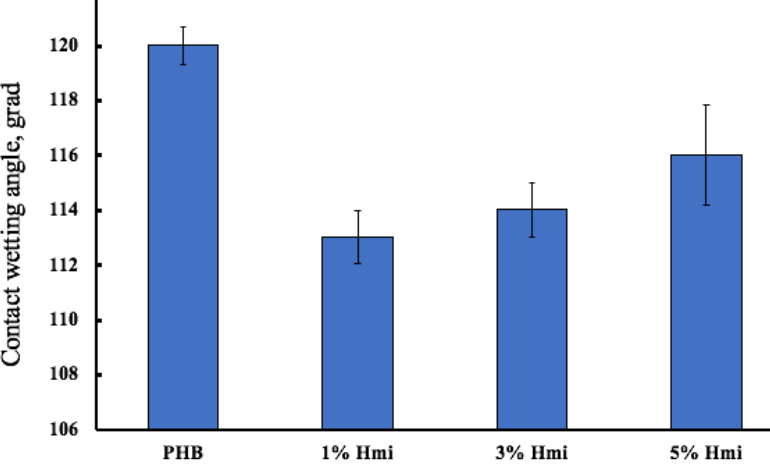
Figure 5. Contact wetting angles of the fibrous materials based on PHB – Hmi.